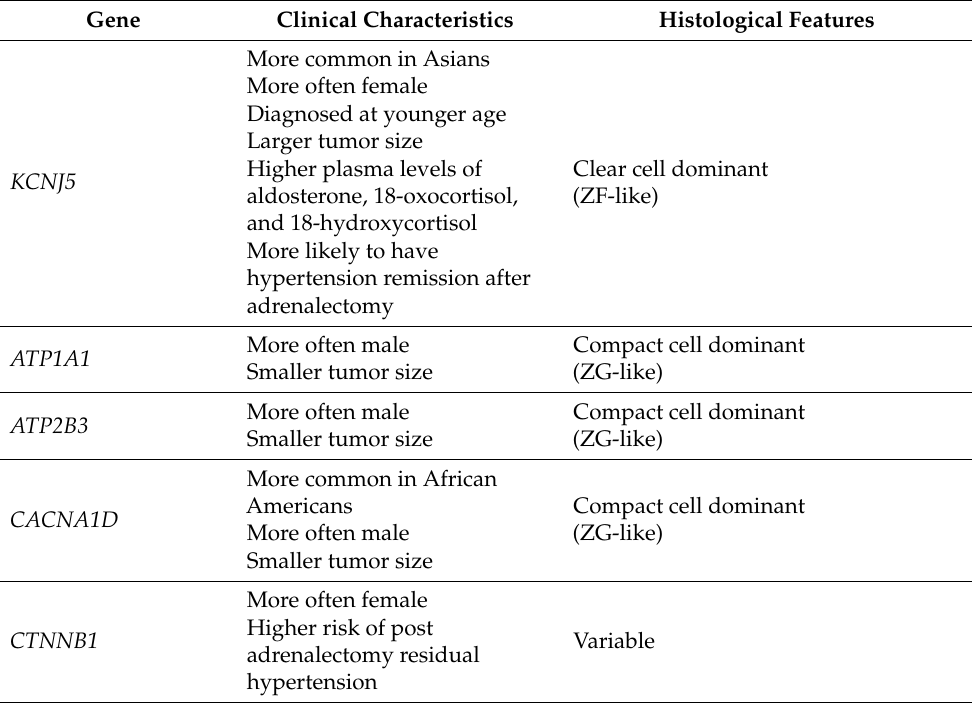
Table 1. Clinical and histological features of APA harboring each somatic